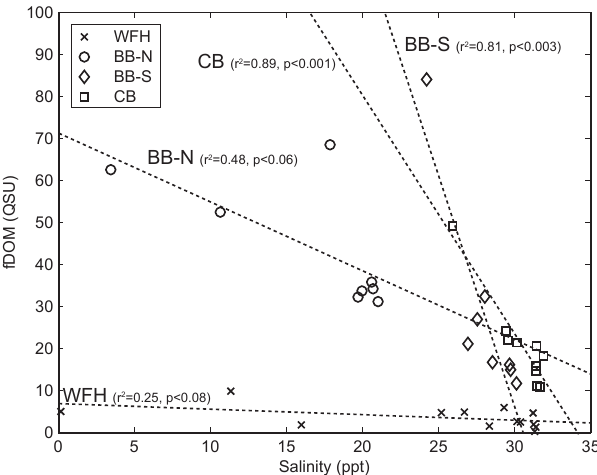
Figure 2. Fluorescence measurement versus salinity for all sample sites at West Falmouth Harbor (WFH), North Barnegat Bay (BB-N), South Barnegat Bay (BB-S), and Chincoteague Bay (CB). Dashed lines indicate the best linear fits to the data, with associated r 2 and p